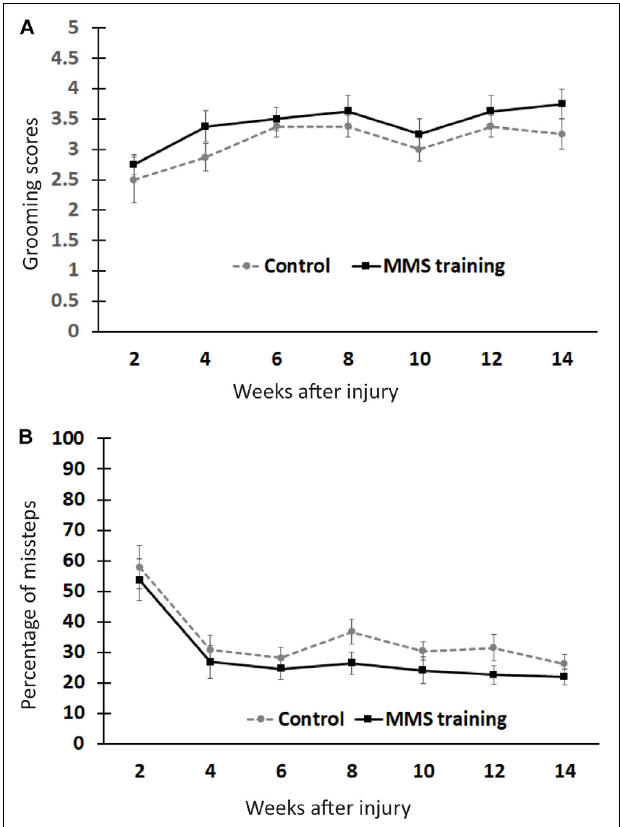
FIGURE 2 | Effect of Modified Montoya Staircase (MMS) rehabilitation on untrained gross forelimb functions. After spinal cord injury (SCI), all rats lost gross forelimb function in the grooming test (A) and horizontal ladder (HL) test (B) . The spontaneous recovery in grooming scores was observed in both MMS rehabilitation and control groups from 6 to 14 weeks post-injury (PI) compared to 2 weeks PI (A) . However, there were no significant differences between the two groups at any tested time points (A) . The percentages of missteps were significantly decreased in both MMS rehabilitation and control groups from 4 to 14 weeks PI compared to 2 weeks PI (B) . The differences between these groups were not significant at any tested time point. Results represent mean ± standard error of the mean (SEM); n = 8 in each group. any tested time point ( Figure 2B ). These data suggest that forelimb